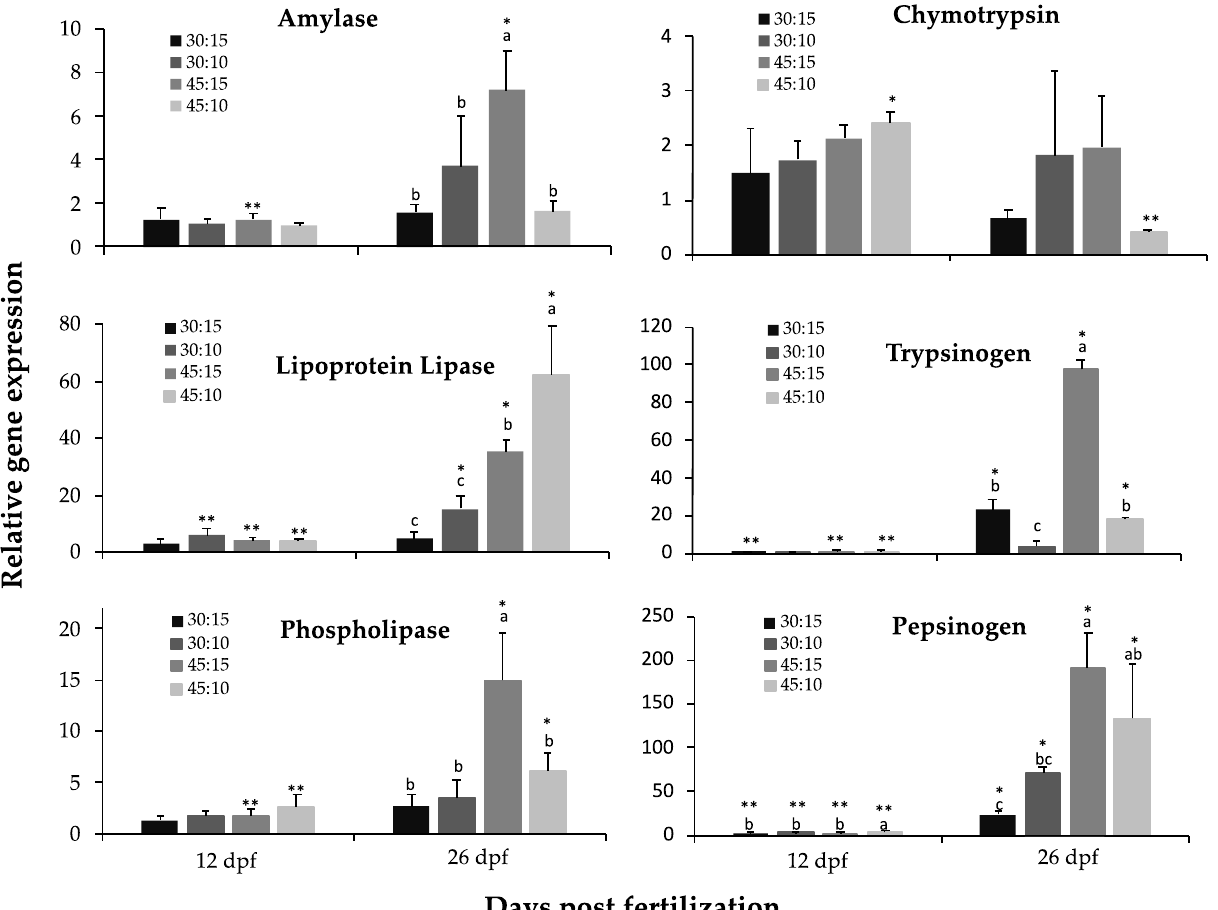
Figure 2. Relative expression of amylase, lipoprotein lipase, phospholipase, chymotrypsin, trypsinogen, and pepsinogen genes during the development of P. punctifer fed the different experimental diets containing different protein:lipid levels (in % of dry matter). Data are represented as means ± S.D. ( n = 3). Values with a different superscript letter denote significant differences between dietary groups of the same age, and values with a different number of asterisks indicate significant differences between days for the same dietary treatment (one-way ANOVA, p < 0.05).